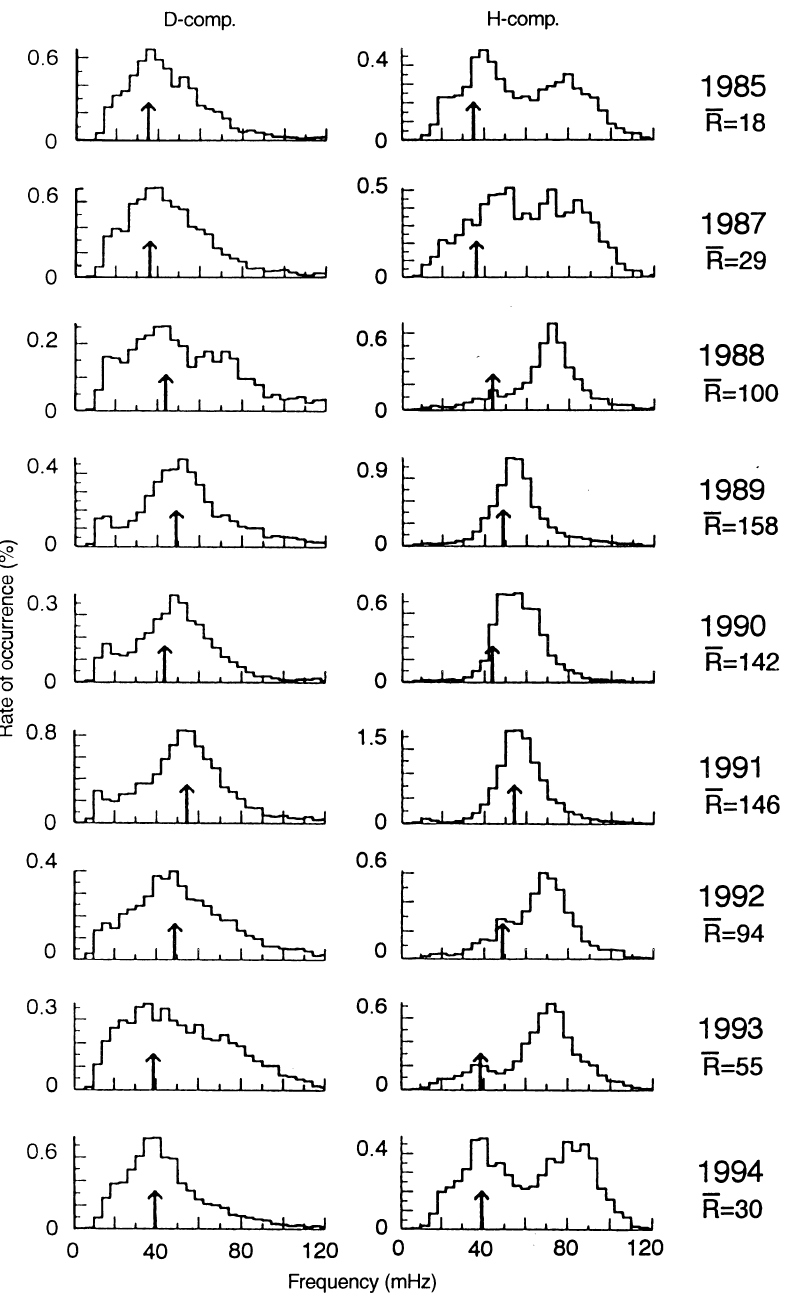
Fig. 8. Frequency distribution of the peaks in the power spectra of the H and D component magnetic field records acquired at a low-latitude ( L (cid:136) 1.6) ground station (adapted from Fig. 1 of Vellante et al ., 1996). The arrows indicate the frequency given by the empirical relation f (mHz) (cid:136) 6 B (nT), where B is the annual IMF IMF average derived from the measurements in the